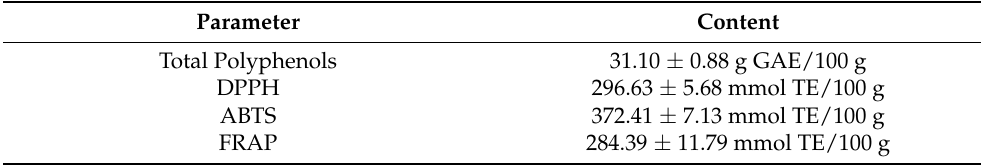
Table 1. Total polyphenols and antioxidant activity of honeysuckle